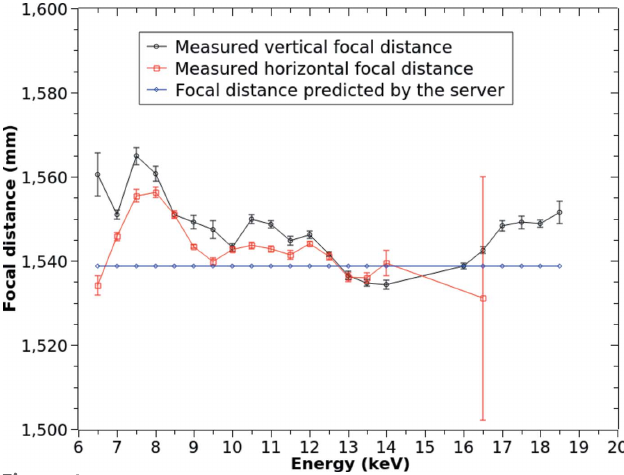
Figure 4 Predicted versus measured focal distances in the energy range from 6.5 to 18.5 keV. The horizontal measurements above 16.5 keV were too noisy and the error bars exceeded the mean deviations; therefore they are excluded. The magnitude of differences (<25 mm) is expanded by the choice of Y -scale. Compared with the 1538.8 mm focal distance, which is the transfocator setpoint, they are minor (less than